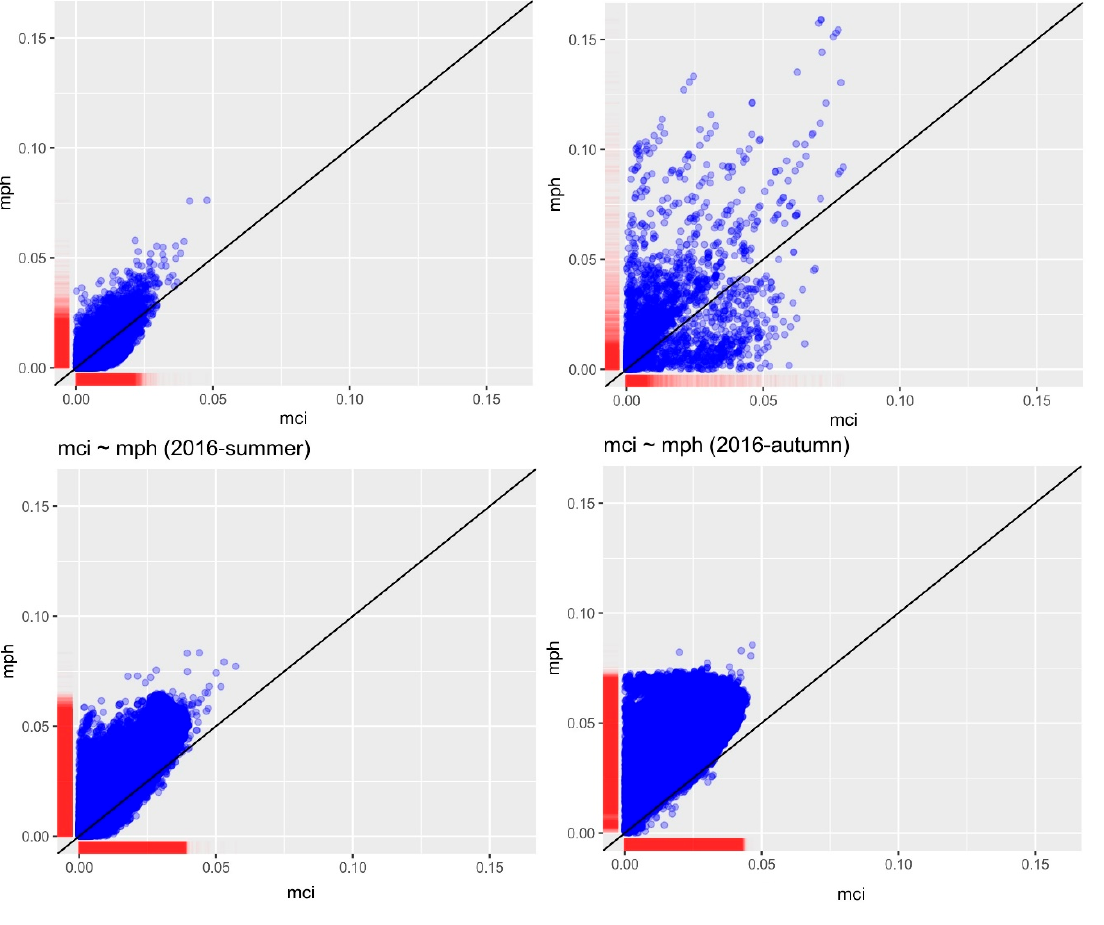
Figure A1. Scatter plot of MCI–MPH for the seasons of 2016.